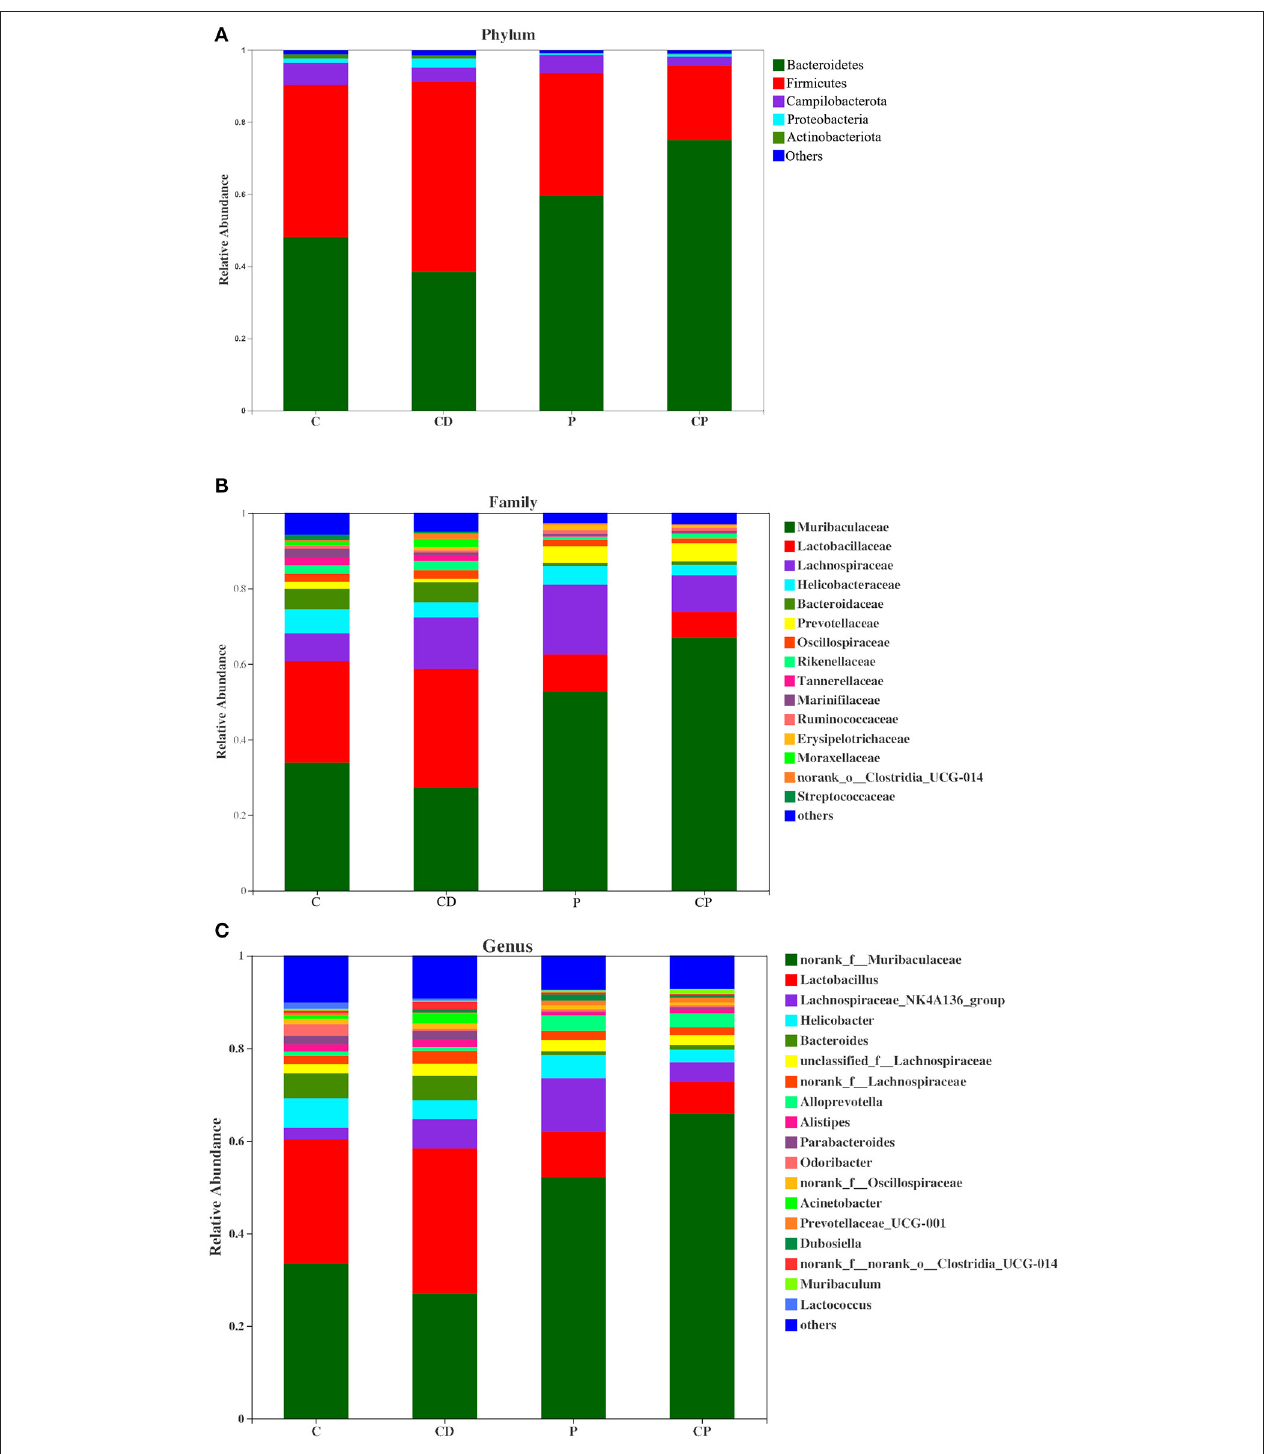
FIGURE 7 | Compositions of microbiota at the phylum (A) , family (B) , and genus levels (C) ( n = 10).